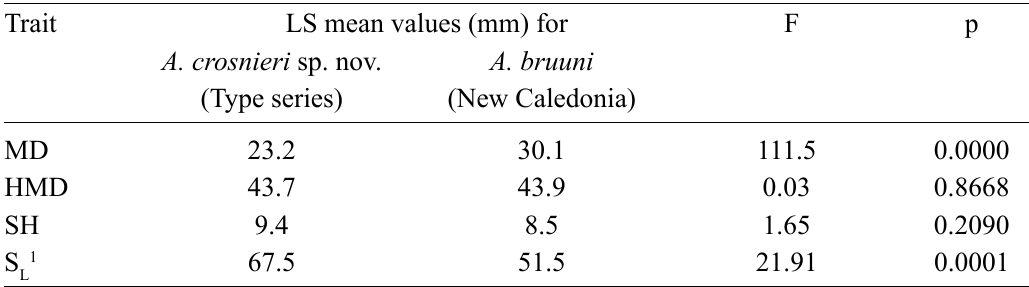
Table 3. Comparison between morphometric parameters for A. crosnieri sp. nov. (N = 14) and A. bruuni (Powell, 1958) (N = 17): Least-squares (LS) means and ANCoVA results. 1 ANoVA results. For the pairwise comparison of mean S : t = -4.68, p = 6.19 × 10 -5 ; u = 211.0, p = 2.80 × 10 -4 L